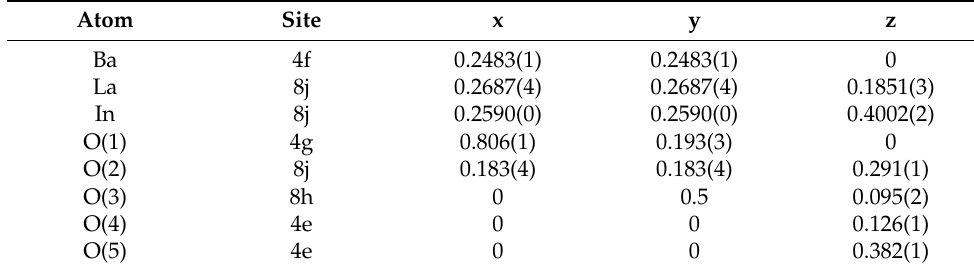
Figure 2. The XRD-data for the composition BaLa 2 In 2 O 7. Table 1. Refined structural parameters from